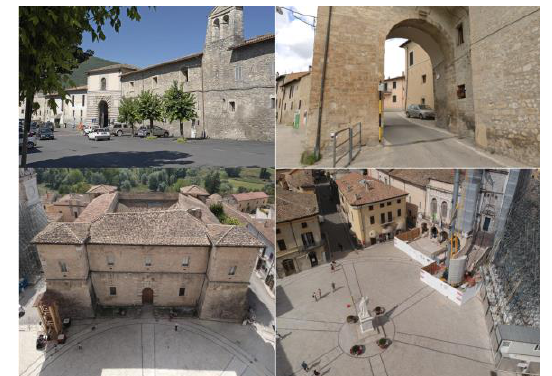
Figure 6. UAV Orthophoto (Geomatics LAB -Politecnico di Torino) with location of the city wall-related structures.